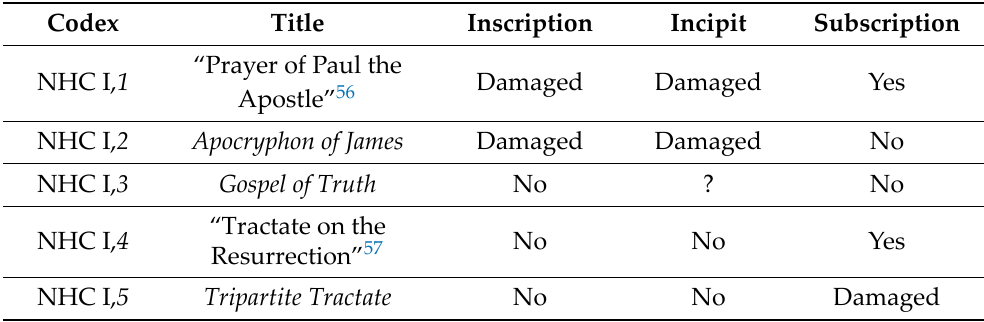
Table 3. Titles in Nag Hammadi Codex